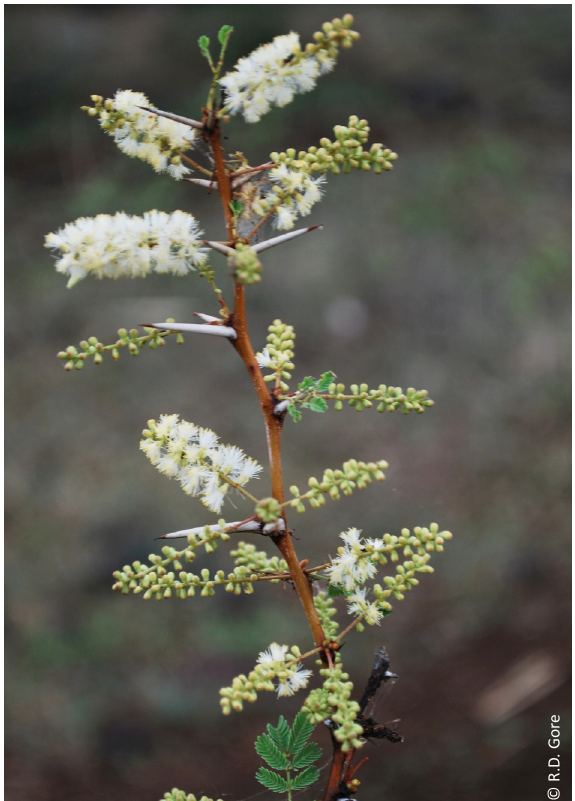
Image 2. Herbarium of Acacia concurrens Pedley. Image 3. Acacia horrida (L.) Willd